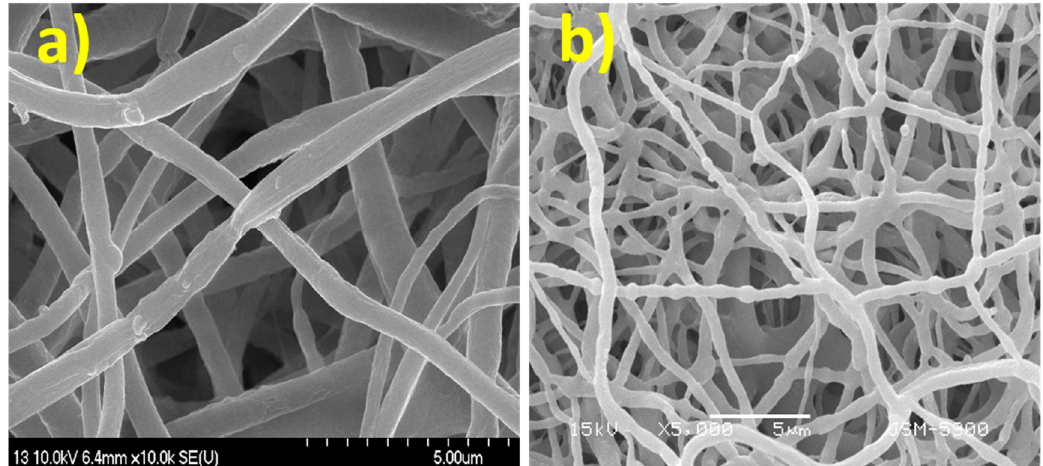
Figure 1. SEM images of the prepared composite nanofibers (NFs) ( a ) before calcination and ( b ) after calcination.